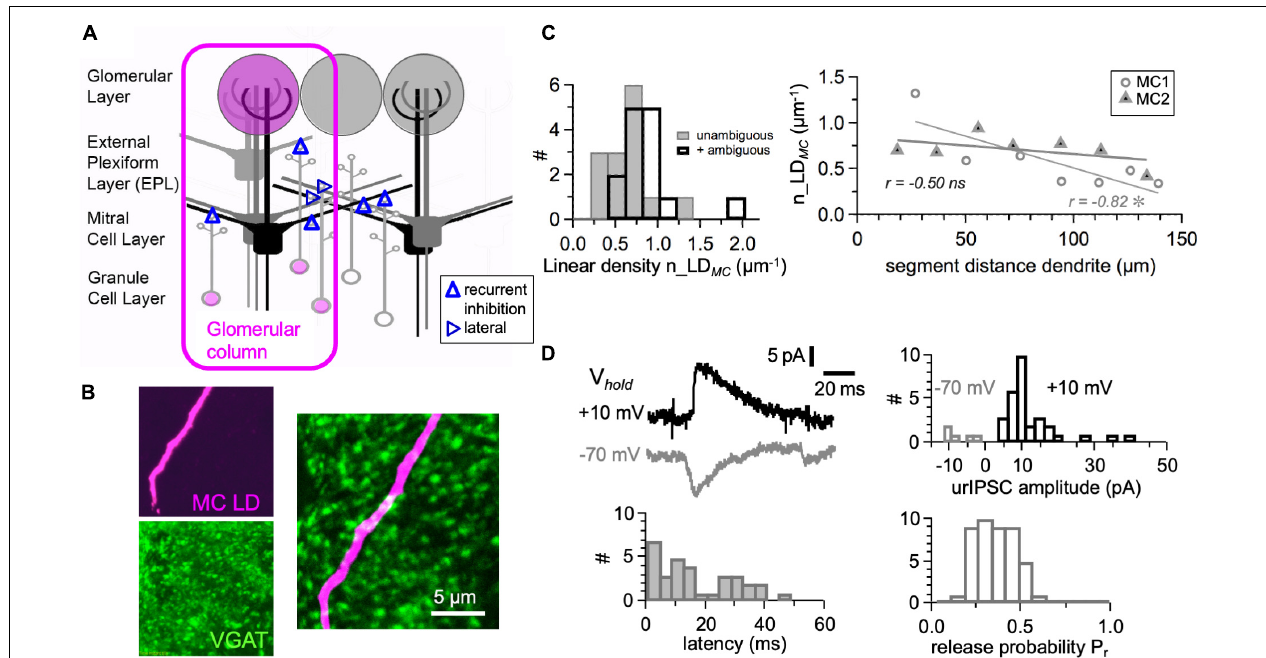
FIGURE 1 | Dendrodendritic interactions between mitral cells and granule cells. (A) Scheme of mitral cell–granule cell network. Glomerular column: Ensemble of mitral cells and granule cells that can be excited from a glomerulus. Recurrent inhibition will occur widely, lateral inhibition can happen only via the granule cells that are sufficiently excited within the columnar ensemble to generate a global or local spike (if at all, see Section “Discussion”). (B) Example double stain of juvenile rat mitral cell lateral dendrite segment and GABAergic presynapses (see Section “Materials and Methods”). Top left: Biocytin label. Bottom left: VGAT-stain. Both z-projections of 5 µ m-deep image stack (sectioning at 0.2 µ m). Right: Overlay of z-projections within a 1 µ m selection of the stack. (C) Cumulative histochemical data: Left: Synaptic input density distribution for certain synapses and upper limit ( n = 14 segments). Right: Density versus distance on the segment. Linear fit (significance of correlation 1-tailed for MC1 P = 0.012, MC2 P = 0.127, n = 7 data points each). (D) Unitary-like mitral cell IPSCs are evoked by uncaging of glutamate onto granule cell spines (data from Lage-Rupprecht et al., 2020). Top left: Averaged example traces from two mitral cells at two different holding potentials ( − 70 mV, + 10 mV) and equilibrium potentials E Cl ( + 16 mV, − 130 mV). Top right, bottom: Distribution of amplitudes, response latencies, and release probabilities (modified from Figure 1 in Lage-Rupprecht et al.,